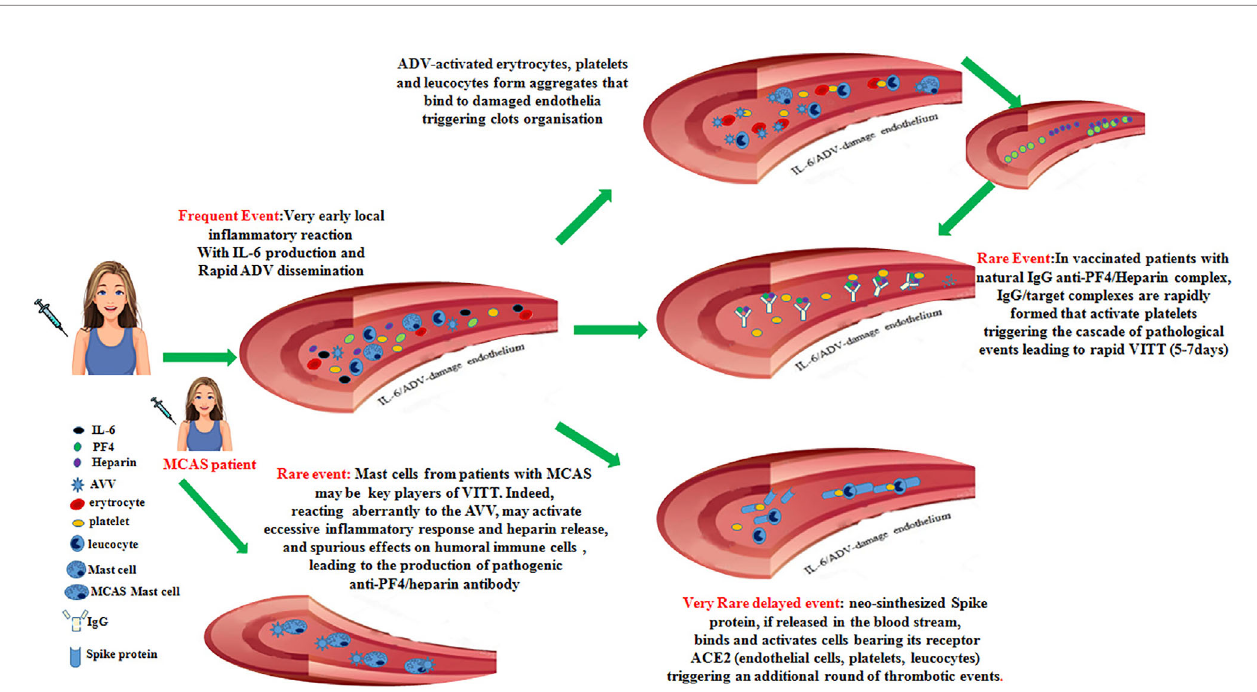
FIGURE 1 | Recapitulates the cascade of pathogenic events that could favor the onset of the vaccine-induced immune thrombotic thrombocytopenia in individuals vaccinated with anti-COVID-19 adenoviral-based